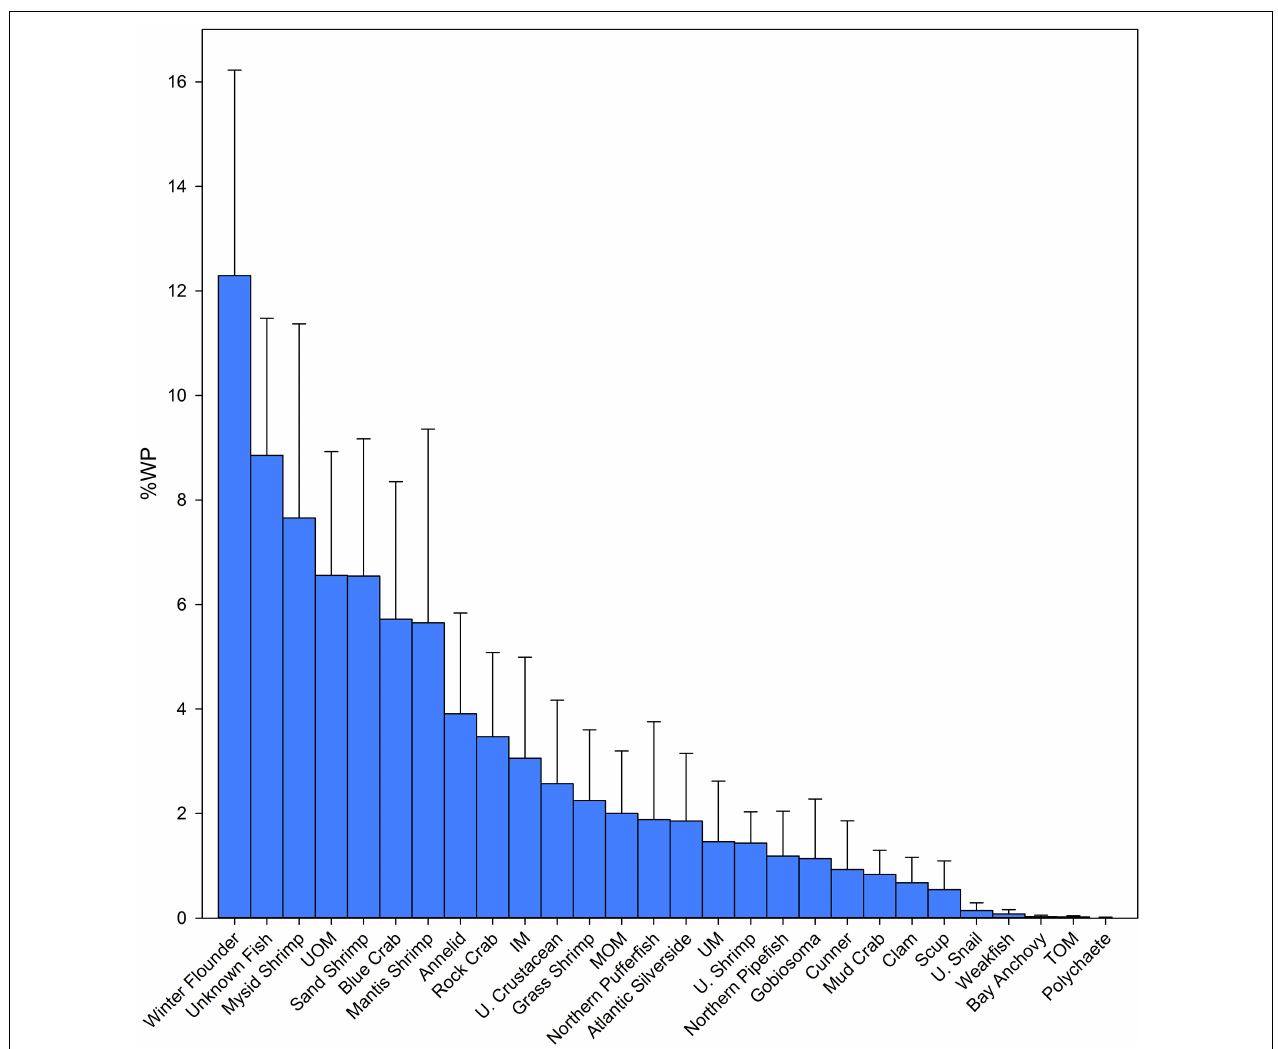
FIGURE 2 | Diet composition in percent weight (Wp%) of summer flounder ( Paralichthys dentatus ) collected in Shinnecock Bay during the summer inshore migration of 2014, 2015, and 2016. Error bars represent standard